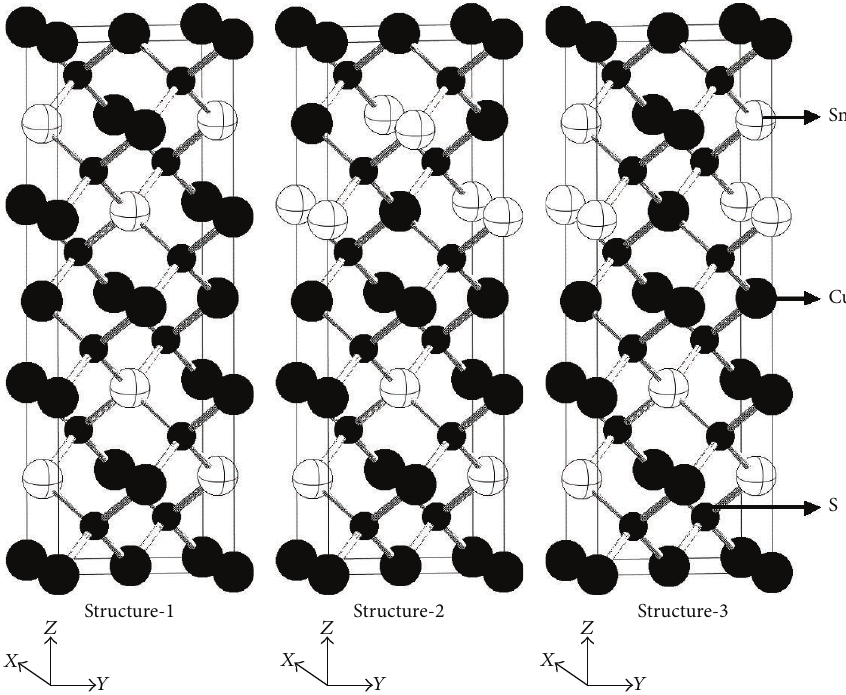
Figure 3: Unit cells for Cu 2 SnS 3 with different position of Cu and Sn atoms in the (Cu, Sn) layers.